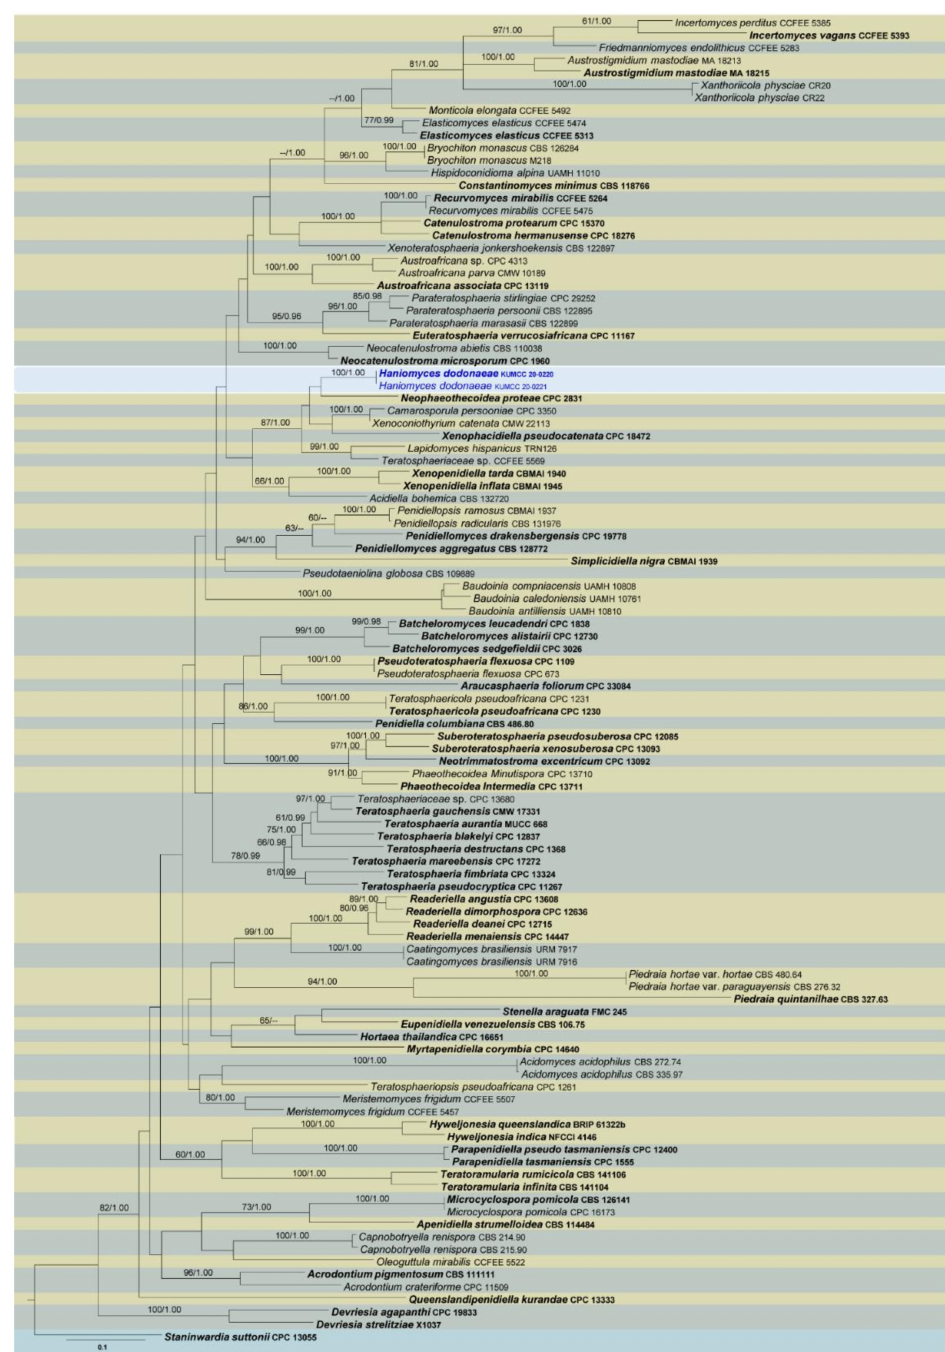
Figure 1. RAxML tree based on a combined dataset of partial LSU, ITS, rpb 2, act , cal and tef 1 DNA sequence analysis in Teratosphaeriaceae. The tree is rooted to Staninwardia suttonii (CPC 13055). Bootstrap support values for ML equal to or greater than 60%, Bayesian posterior probabilities (BYPP) equal to or greater than 0.95 are presented as ML/BI above nodes. Known genera are indicated with coloured blocks. Blue represents new isolates. The ex-type strains are indicated in bold . The scale bar presents the expected number of nucleotide substitutions per